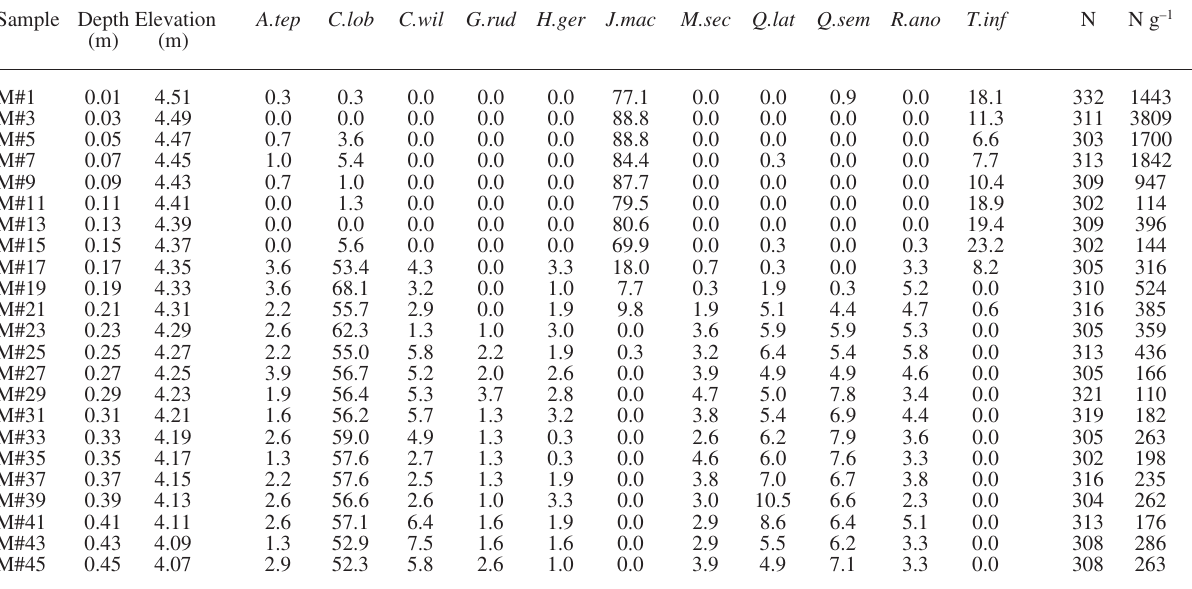
Table 1. – relative abundances (>2%) of main foraminiferal species in the muskiz core samples. A.tep, Ammonia tepida ; C.lob, Cibicides lobatulus ; C.wil, Cribroelphidium williamsoni ; G.rud, Gaudryina rudis ; H.ger, Haynesina germanica ; J.mac, Jadammina macrescens ; M.sec, Massilina secans ; Q.lat, Quinqueloculina lata ; Q.sem, Quinqueloculina seminula ; R.ano, Rosalina anomala ; T.inf, Trochammina inflata ; n, number of test